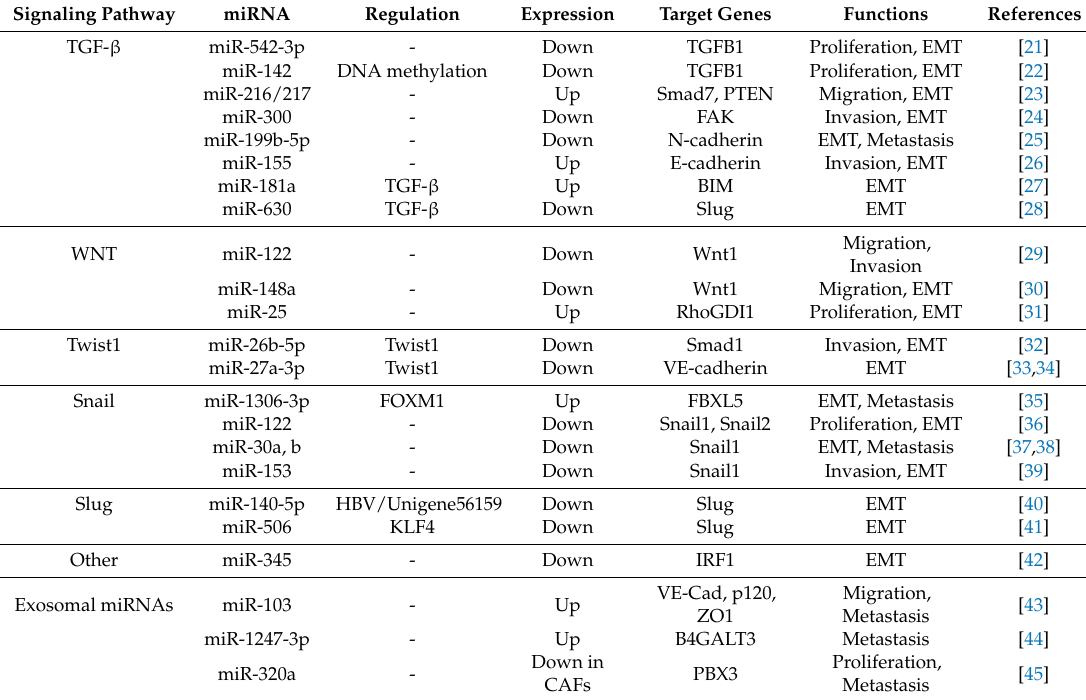
Table 1. Epithelial–mesenchymal transition (EMT)-related miRNAs and their target genes in hepatocellular carcinoma